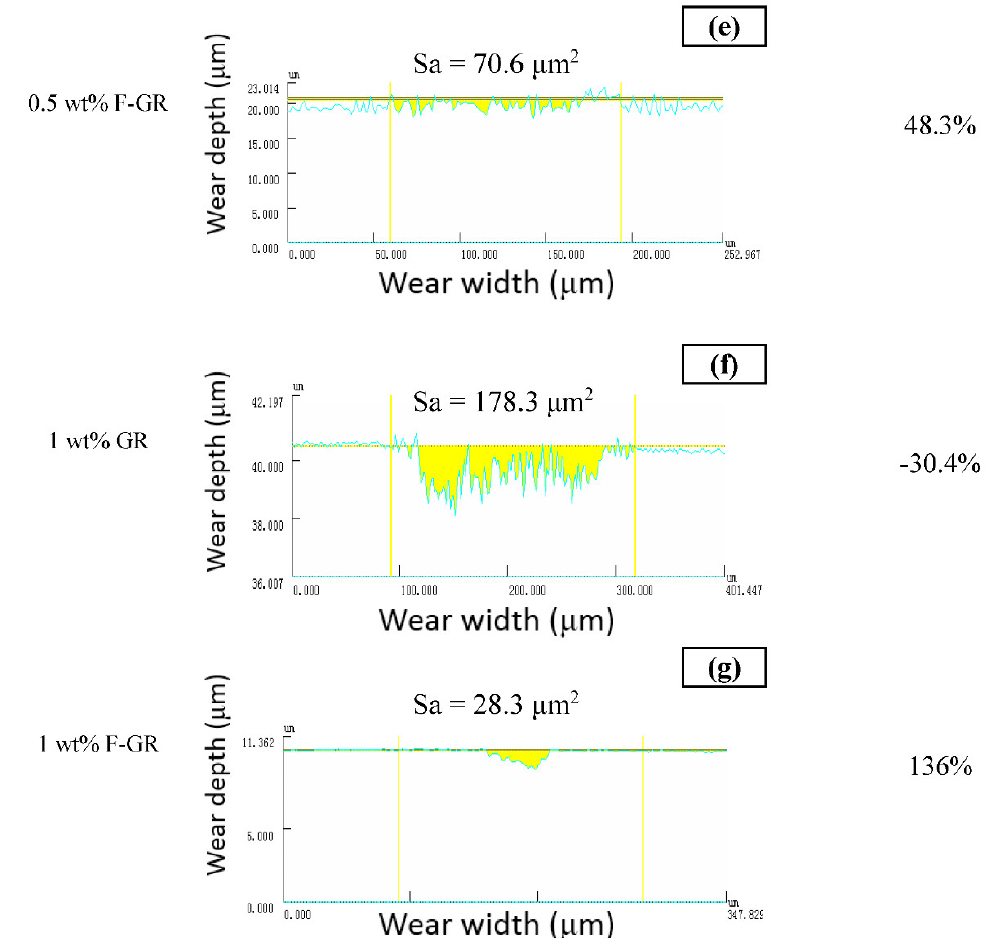
Figure 7. Crossing areas of wear traces of disks lubricated with different oil samples at 50 N and 10 mm/s for 60 min. ( a ) PAO6, ( b ) 0.1 wt% GR, ( c ) 0.1 wt% F-GR, ( d ) 0.5 wt% GR, ( e ) 0.5 wt% F-GR, ( f ) 1 wt% GR, ( g ) 1 wt% F-GR.